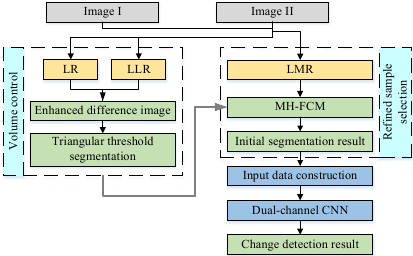
Figure 1. Flowchart of proposed method.